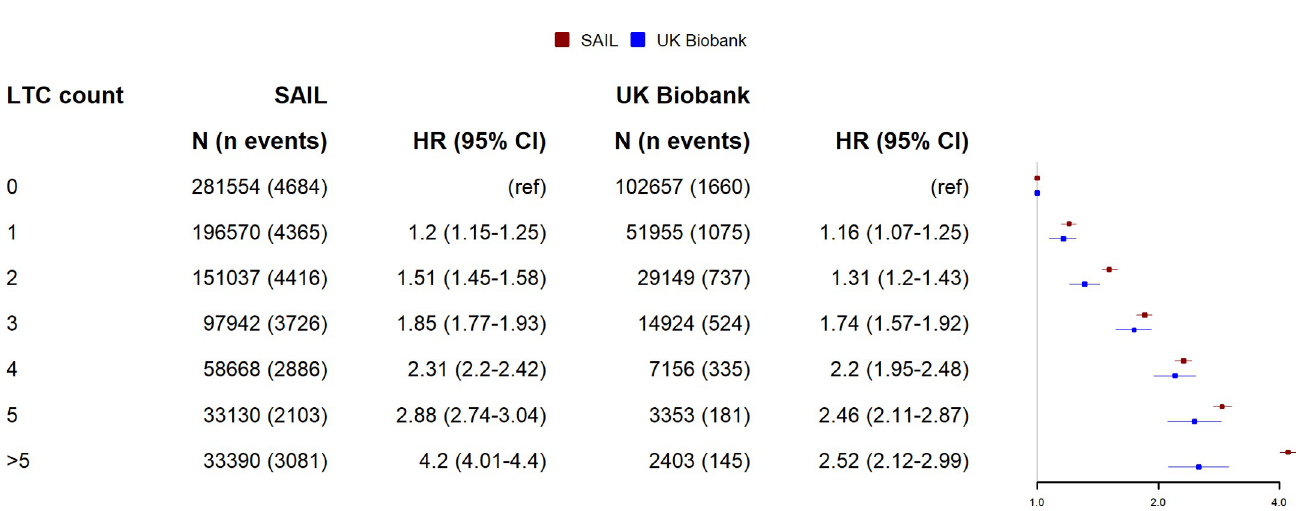
Fig 8. Relationship between LTC count and incident rate ratio for unscheduled hospitalisation in UK Biobank and SAIL. Points indicate HRs adjusted for age, sex, and socioeconomic status. Whiskers indicate 95% CIs. N = total number of participants per LTC count, n events = number of events. CI, confidence interval; HR, hazard ratio; LTC, long-term condition; SAIL, Secure Anonymised Information Linkage.